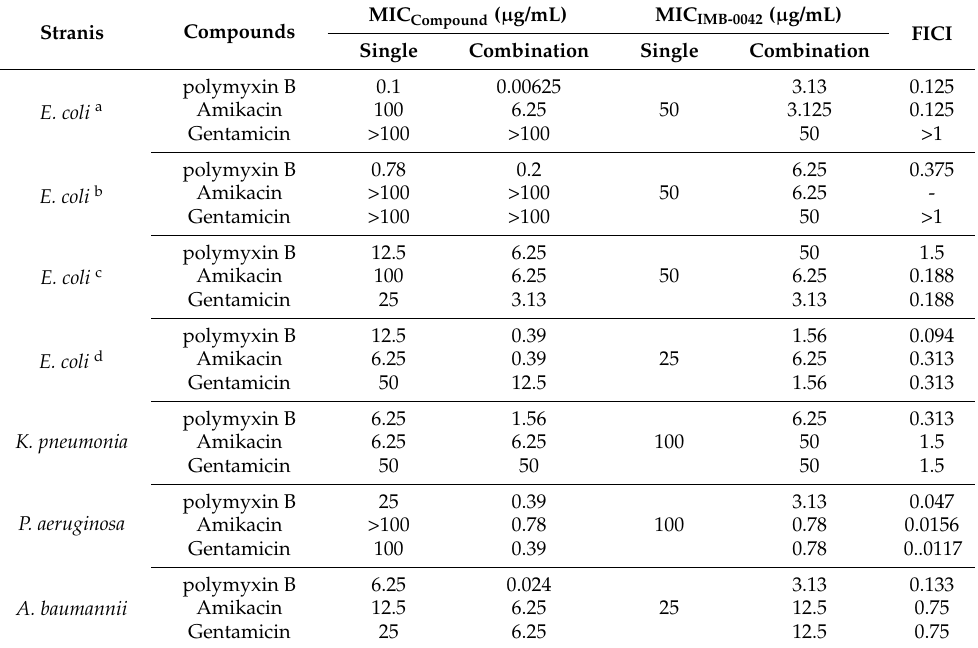
Table 3. The synergetic effect of IMB-0042 with other antibiotics against clinical isolates of E. coli and other Gram-negative